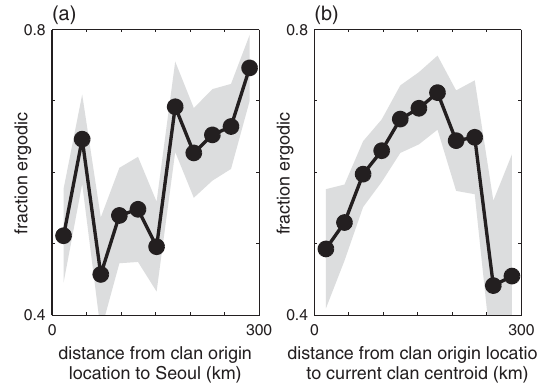
FIG. 23. Fraction of ergodic clans and distance scales of clans using only the 3 120 clans that we employed for the calculations in Fig. 22. We obtain the same qualitative result as in Fig. 5 in the main text. (a) Fraction of ergodic clans versus distance to Seoul. The correlation between the variables is positive and statistically significant. (The Pearson correlation coefficient is r ≈ 0 . 70 , and the p -value is p ≈ 0 . 02 .) For the purpose of this calculation, we call a clan “ ergodic ” if it is present in at least 150 administrative regions. (b) Fraction of ergodic clans versus the distance between the location of clan origin and the present-day centroid. We measure ergodicity as in the left panel, and we estimate the fraction separately for each range of binned distances. (We use the same bins as in the left panel.) The correlation between the variables is positive and significant up to 170 km ( r ≈ 0 . 99 , p ≈ 0 . 0001 ) and is negative and significant for larger distances ( r ≈ − 0 . 92 , p ≈ 0 . 01 ). For each of the panels, we estimate the fraction of ergodic clans in each of 11 equally-sized bins for the displayed range of distances. The gray regions give 95% con- fidence